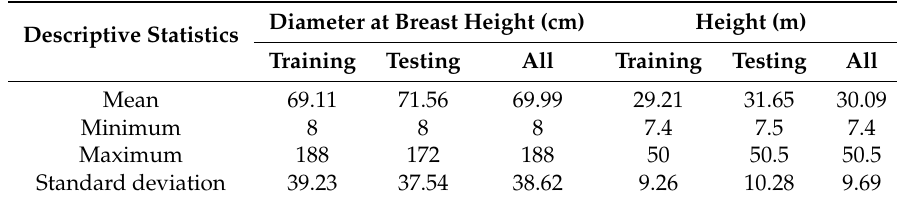
Table 1. Statistical characteristics of the diameter at breast height (DBH) and total height measurements of trees.